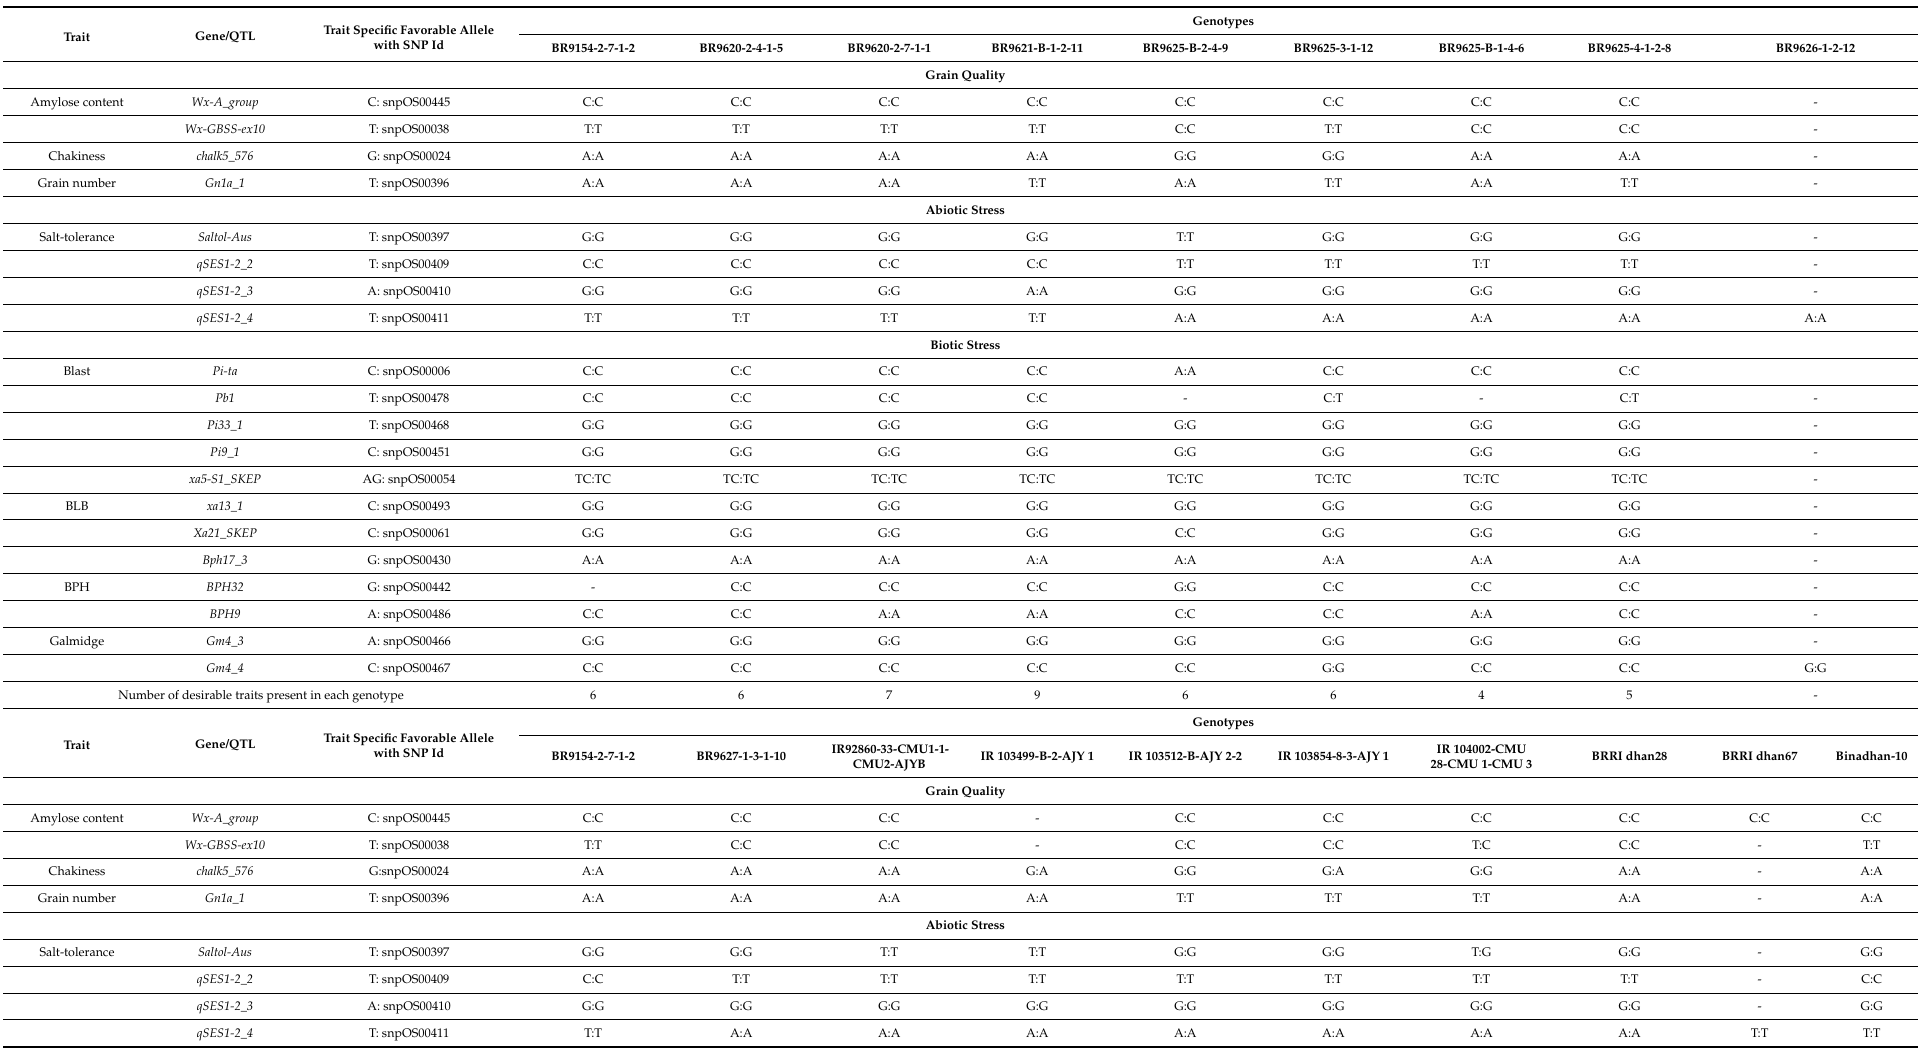
Table 1. List of the gene-based SNP markers with favorable alleles used to characterize 18 advanced breeding lines for the different traits of interest. Trait Gene/QTL TraitSpecificFavorableAllele